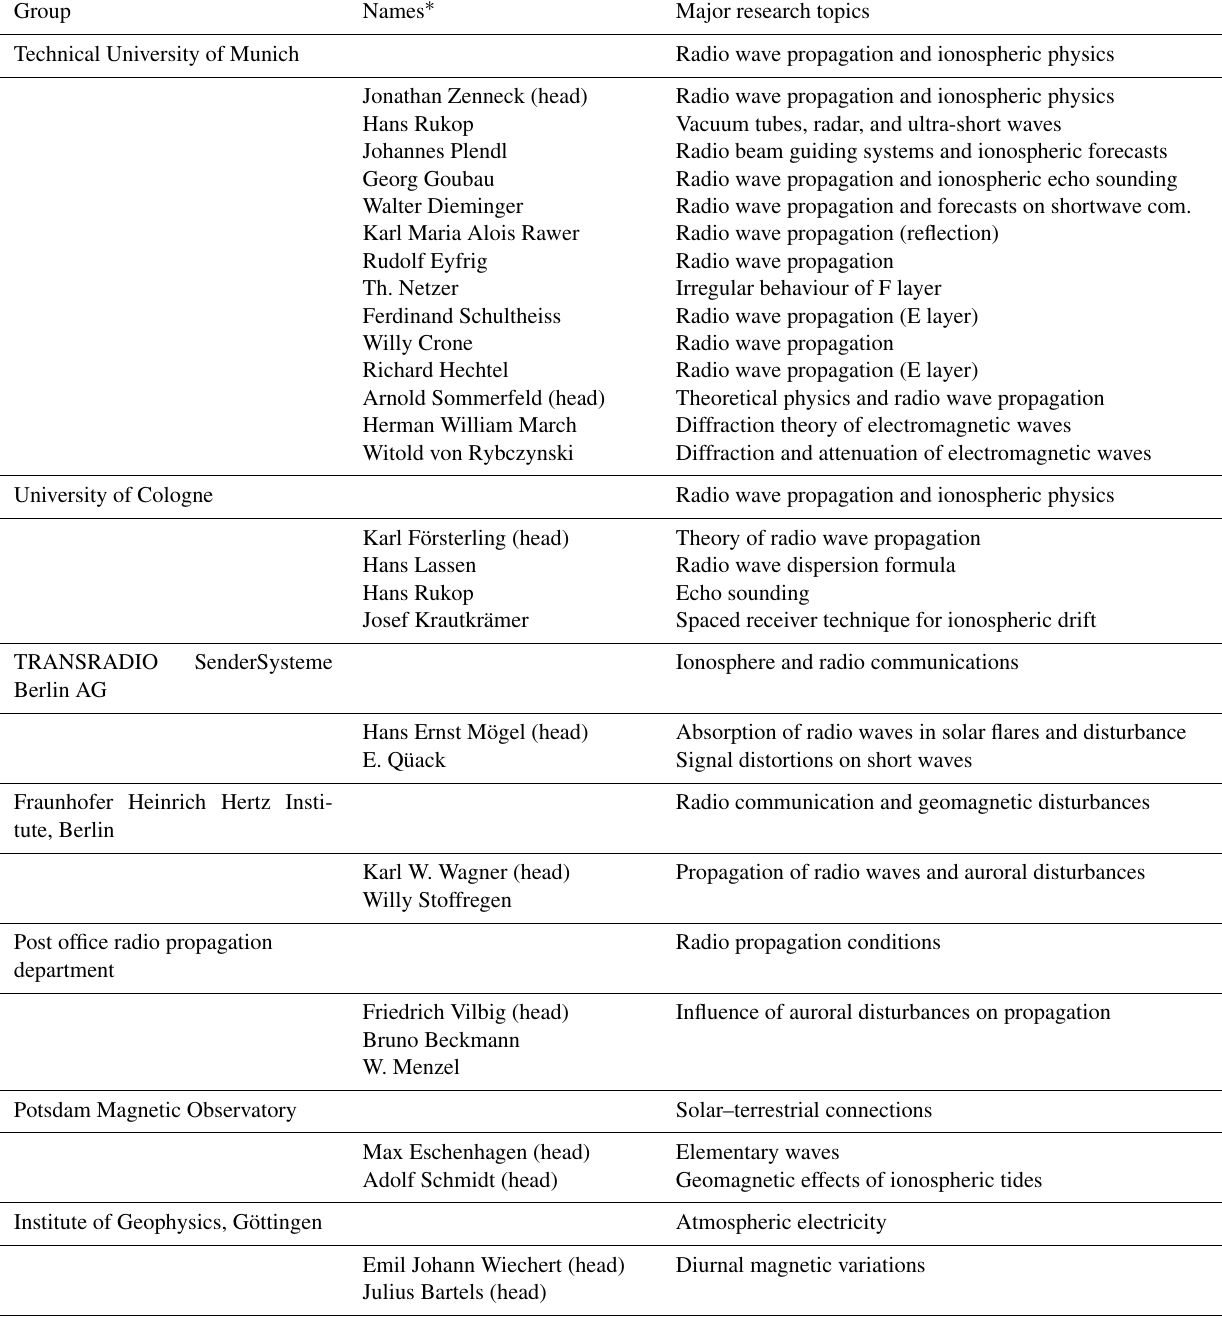
Table 3. Ionospheric physics in Germany in the interwar years. Groups and major research topics.